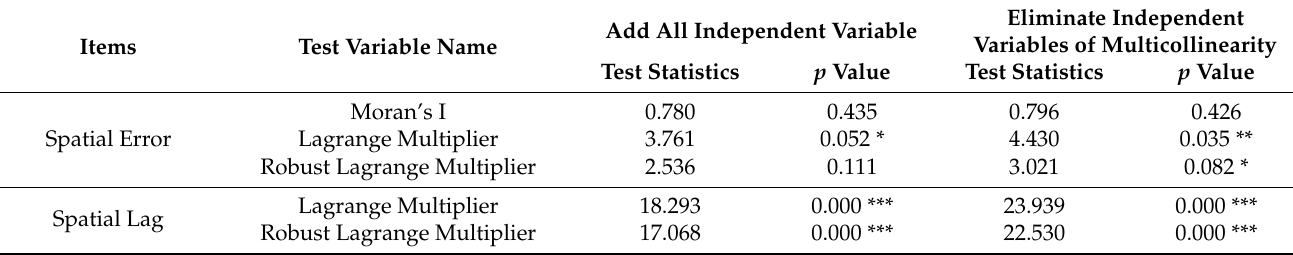
Table 3. Spatial autocorrelation test